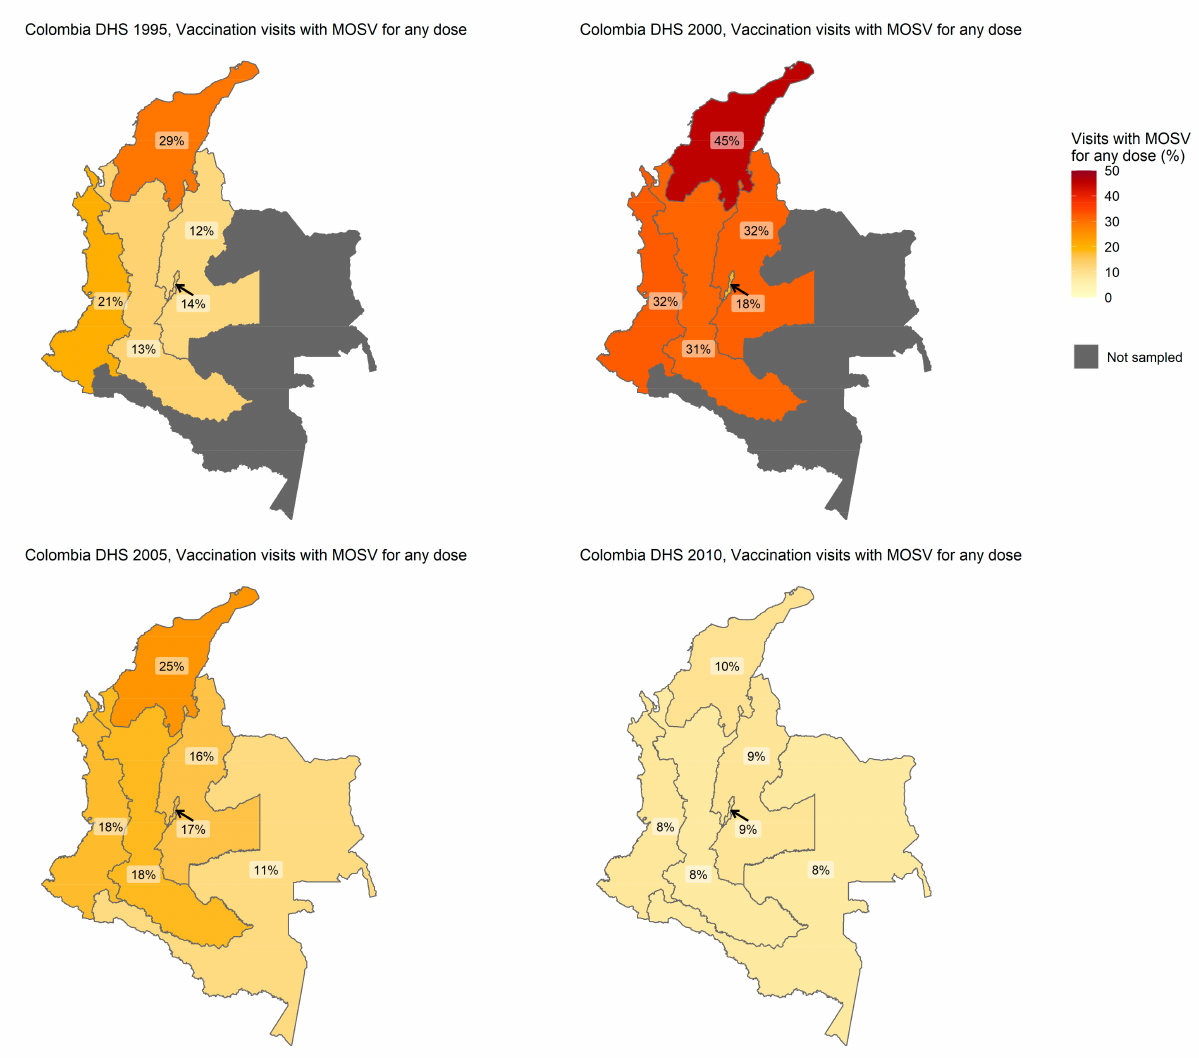
Figure 2. Percent of vaccination visits with one or more MOSVs, Colombia, 1995–2010. Map disclaimer: The boundaries and names shown, and the designations used on this map do not imply the expression of any opinion whatsoever on the part of the World Health Organization concerning the legal status of any country, territory, city or area or of its authorities or concerning the delimitation of its frontiers or boundaries. Dotted and dashed lines on maps represent approximate border lines for which there may not yet be full